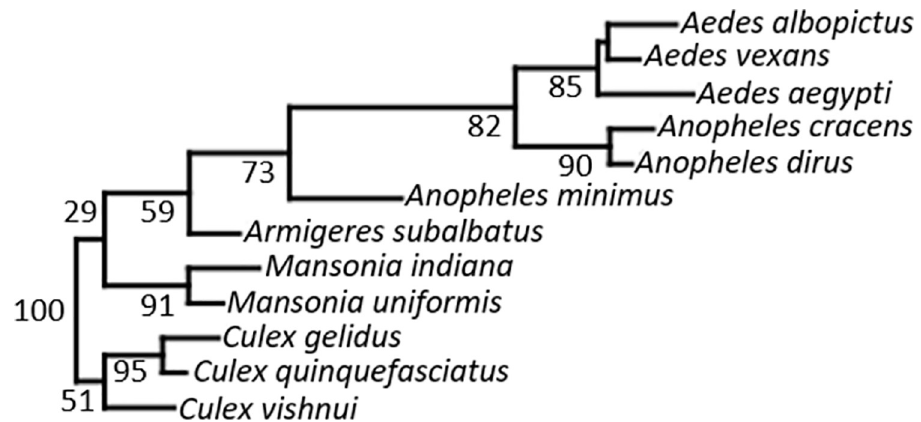
Fig 5. Neighbor-Joining tree showing phenetic wing morphology relationships among mosquito species. The tree was constructed based on the Mahalanobis distances between species.